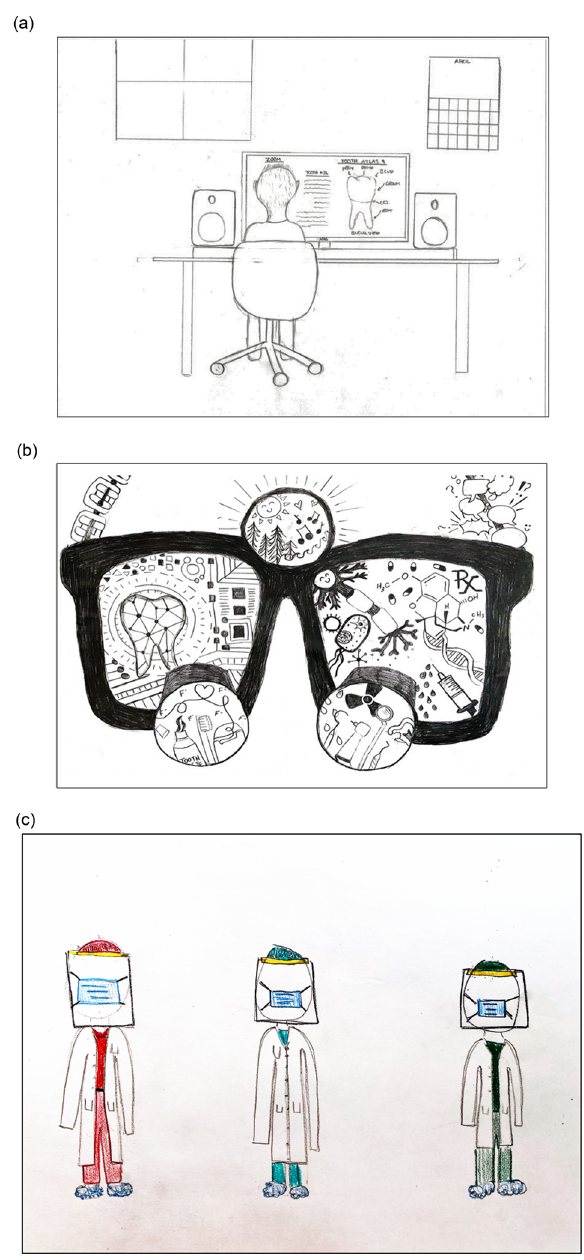
Fig. 1 Three artwork created by Year-1 dental students (Millen- nials and Generation Z) showing some features illustrating the three Themes for this group (see Table 2). Theme 1: student studying on their own at home ( a ), and lack of touching between friends and the required social distance ( c ). Themes 2 and 3: ( b ) basic and preclinical knowledge inside the glass lens, which is repre- sented by chemical formulas, a neural axon, graphs, a diagram- tooth, sodium hypochlorite syringe etc., with these graphics also indicating ‘ the present ’ ; and clinical dentistry inside the magni fi cation lens, which is represented by tooth paste, dental fl oss, fl uoride symbols, radiology symbols, dental handpieces with burs, a cavitated tooth and a heart (probably a caries diagnosis and management situation), with these graphics also indicating ‘ aspira- tions for the future ’ ; unique hair and ears of a person at home ( a ), and distinct heights and hairstyles of three classmates ( c